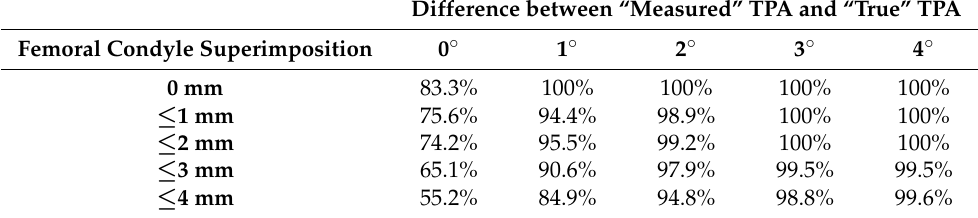
Table 1. Frequency of results of various radiographic positions as determined by degree of femoral condylar superimposition, for range of differences between “measured” TPA and “true” TPA. Difference between “Measured” TPA and “True” TPA Femoral Condyle Superimposition 0 ◦ 1 ◦ 2 ◦ 3 ◦ 4 ◦ 0 mm 83.3% 100% 100% 100% 100% ≤ 1 mm 75.6% 94.4% 98.9% 100% 100% ≤ 2 mm 74.2% 95.5% 99.2% 100% 100% ≤ 3 mm 65.1% 90.6% 97.9% 99.5% 99.5% ≤ 4 mm 55.2% 84.9% 94.8% 98.8%